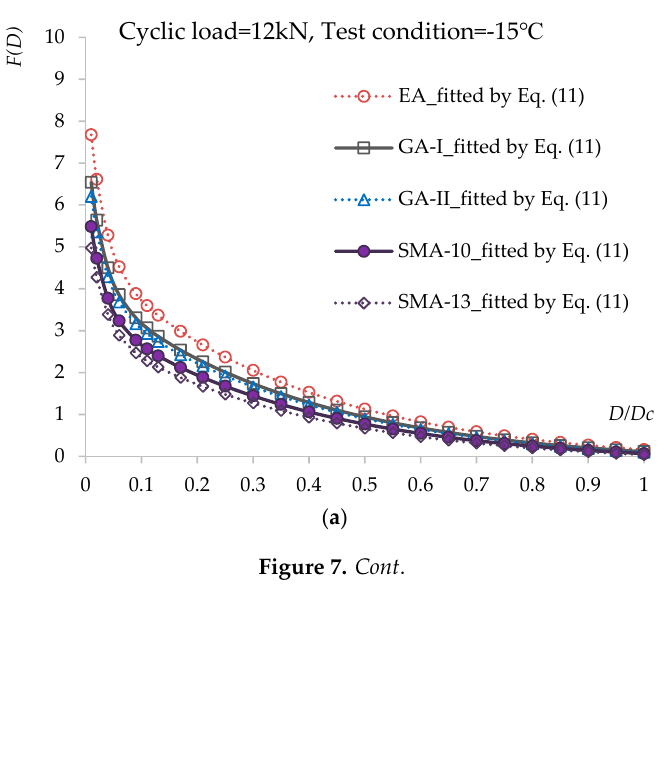
Figure 6. Relationship between x = N / N f and D = D i / D C under di ff erent loading cycle levels and test conditions: ( a ) cyclic load = 12 kN, test condition = − 15 ◦ C; ( b ) cyclic load = 12 kN, test condition = 20 ◦ C; ( c ) cyclic load = 12 kN, test condition = 60 ◦ C; ( d ) cyclic load = 16 kN, test condition = − 15 ◦ C; ( e ) cyclic load = 16 kN, test condition = 20 ◦ C; ( f ) cyclic load = 16 kN, test condition = 60 ◦ C. The trends in the critical active energy change caused by damage evolution under loading cycle levels of 12 and 16 kN and test conditions of − 15, 20, and 60 °C for the fatigue tests are shown in Figure 7a – f. The results fitted by Equation (11) are also displayed in Figure 7 as curves. The fitted results are in good agreement with the experimental results, which suggests that Equation (11) can characterize the relationship between accumulated energy and damage evolution i C well.